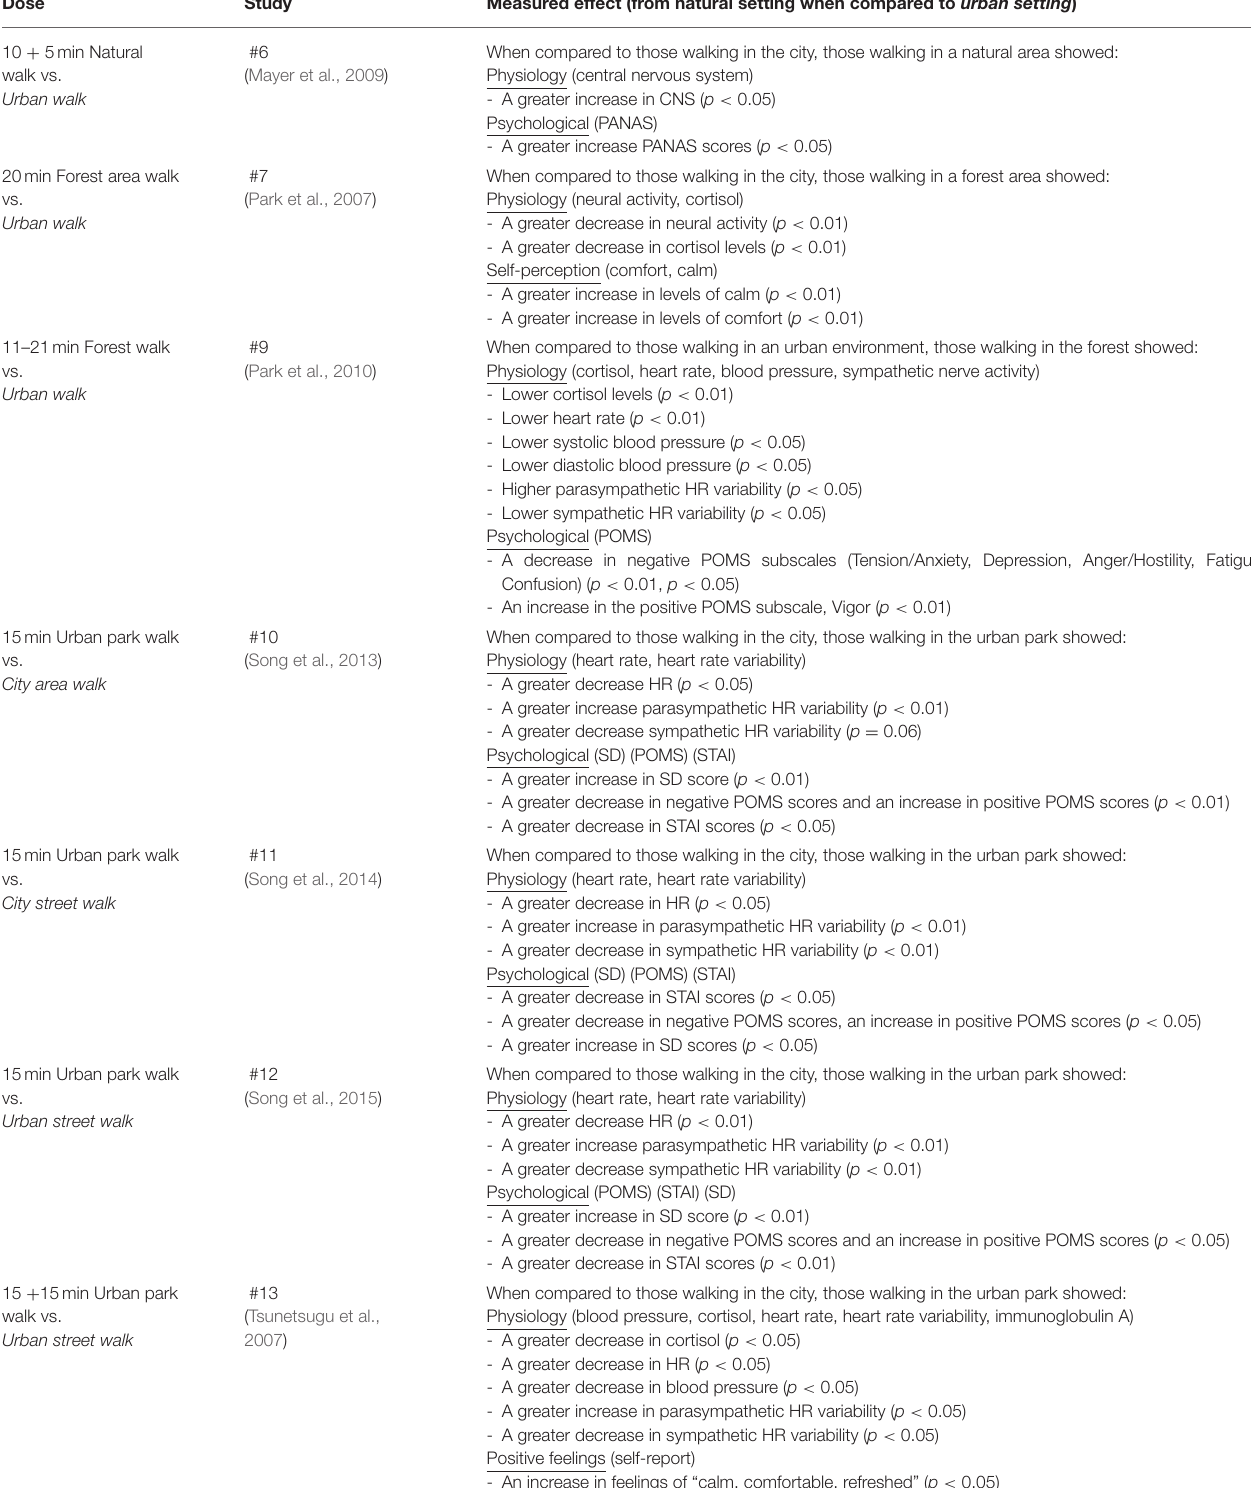
TABLE 4 | Measured effects of time in nature via included studies 10–30min of walking outdoors: natural vs. urban setting. Dose Study Measured effect (from natural setting when compared to urban setting ) 10 + 5min Natural walk